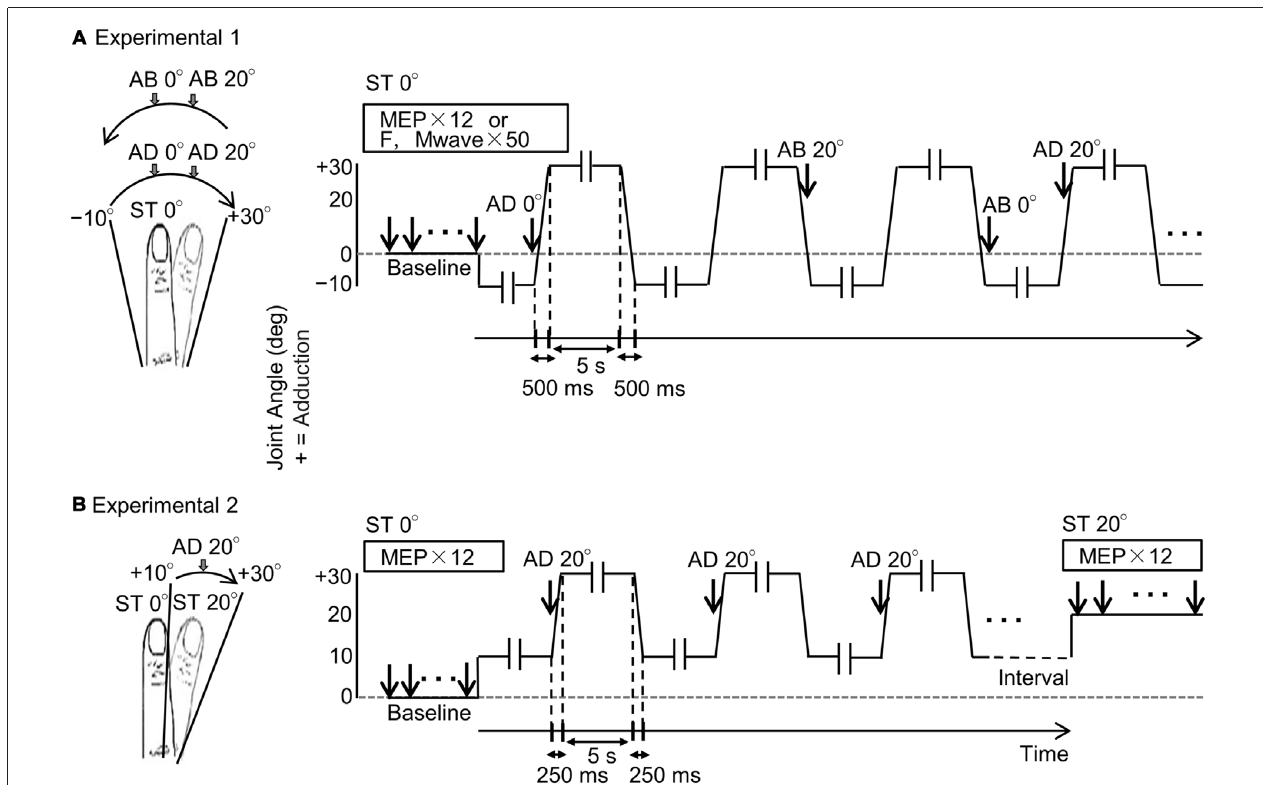
FIGURE 1 | Experimental protocols. (A) Schema of Experiment 1. The left diagram shows the right index finger and its range of movement, and the right diagram shows joint angle and measurement timings for motor evoked potentials (MEPs), F-waves and M-waves during passive movement. The vertical and horizontal axes represent joint angle and time, respectively. MEPs, M-waves and F-waves were measured randomly in one adduction–abduction cycle in only one condition. Velocity of the passive movement was 80 ◦ /s and the range of movement was from 10 ◦ abduction to 30 ◦ adduction. Movement from 10 ◦ abduction to 30 ◦ adduction took 500 ms and a 5-s pause was included between changes in direction (-ll-). MEPs, M-waves and F-waves were measured on different days. Baseline (ST 0 ◦ ): 0 ◦ static joint angle; AD 0 ◦ : 0 ◦ joint angle during passive adduction; AD 20 ◦ : 20 ◦ adduction (joint angle) during passive adduction; AB 20 ◦ : 20 ◦ adduction (joint angle) during passive abduction; AB 0 ◦ : 0 ◦ joint angle during passive abduction. (B) Schema of Experiment 2. The diagrams correspond to those in (A) . The MEP was measured only once during a single adduction–abduction cycle at 20 ◦ adduction during passive adduction from 10 ◦ to 30 ◦ . Baseline (ST 0 ◦ ): 0 ◦ static joint angle; AD 0 ◦ : 0 ◦ joint angle during passive adduction; ST 20 ◦ : 20 ◦ static adduction angle. Velocity of passive movement was 80 ◦ /s. Movement from 10 ◦ abduction to 30 ◦ adduction took 250 ms (125 ms from 10 ◦ adduction to 20 ◦ adduction) with 5-s pauses (-ll-) between changes in